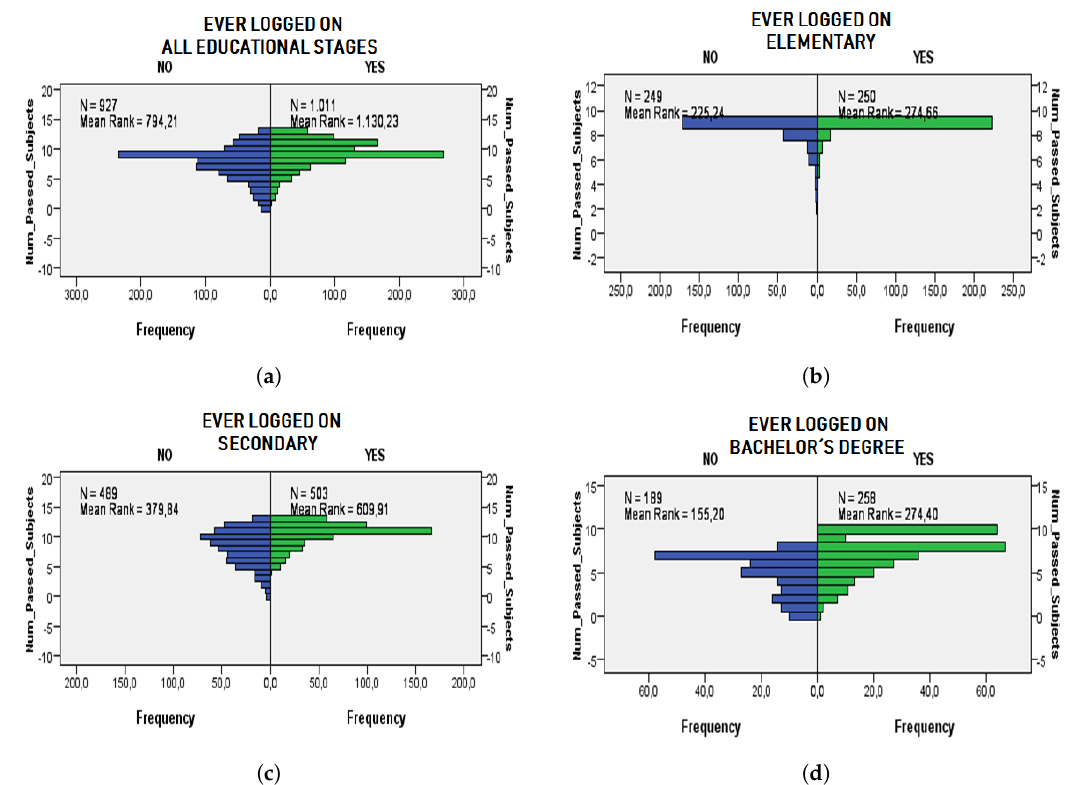
Figure 1. Statistical differences according to the Mann-Whitney test considering if there is any relation between accessing or not accessing the LMS and the number of passed subjects. The right side of the subfigures (in green color) represents the students who have logged into the LMS and the left side (blue color) represents the students who have not logged into the LMS. ( a ) Differences between the number of passed subjects for students accessing and not accessing the LMS considering all the educational stages. ( b ) Differences between the number of passed subjects for students accessing and not accessing the LMS considering the elementary stage. ( c ) Differences between the number of passed subjects for students accessing and not accessing the LMS considering the secondary